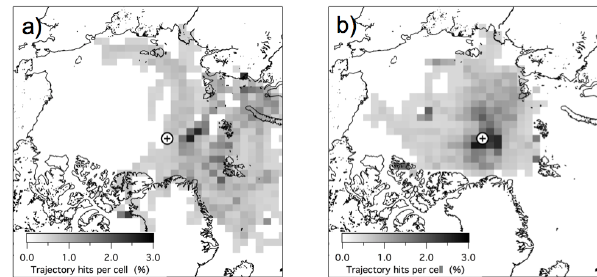
Figure 6. (a) Geographic distribution of trajectories of the marginal ice subpopulations, and (b) geographic distribution of trajectories of all data in the pack ice